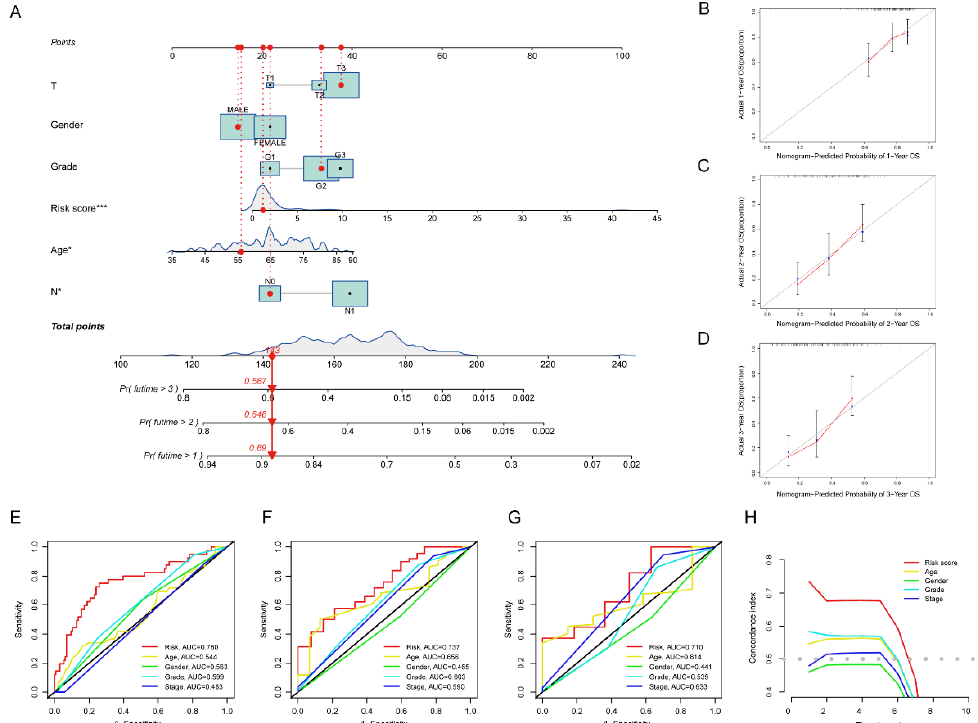
Figure 6. Identifying the Predictive Capability of Risk Signatures for Prognosis. ( A ) Establishment of a nomogram based on the signature to predict the 1-, 2-, and 3-year OS. ( B ) One-year nomogram calibration curves of the TCGA cohort. ( C ) Two-year nomogram calibration curves of the TCGA cohort. ( D ) Three-year nomogram calibration curves of the TCGA cohort. ( E – G ) The time-dependent ROC of the nomogram based on the OS. ( H ) The concordance index (c-index) for the risk signature and other clinical characteristics. * p < 0.05, *** p < 0.001.